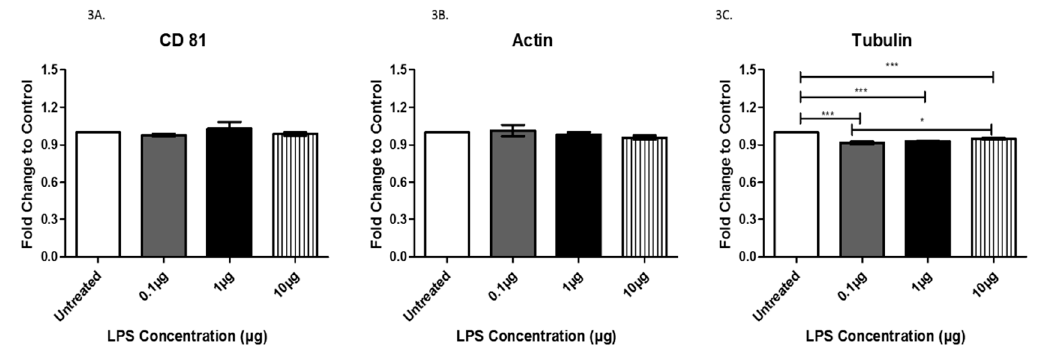
Figure 3. The expression of CD81 ( A ), actin ( B ), and tubulin ( C ) was determined by ELISA in exosomes from AC16 cells that were treated with different concentrations of LPS or left untreated. Data are shown as means ± SEM from a total of five experiments. Significance is indicated by * p ≤ 0.05 and *** p ≤ 0.001.